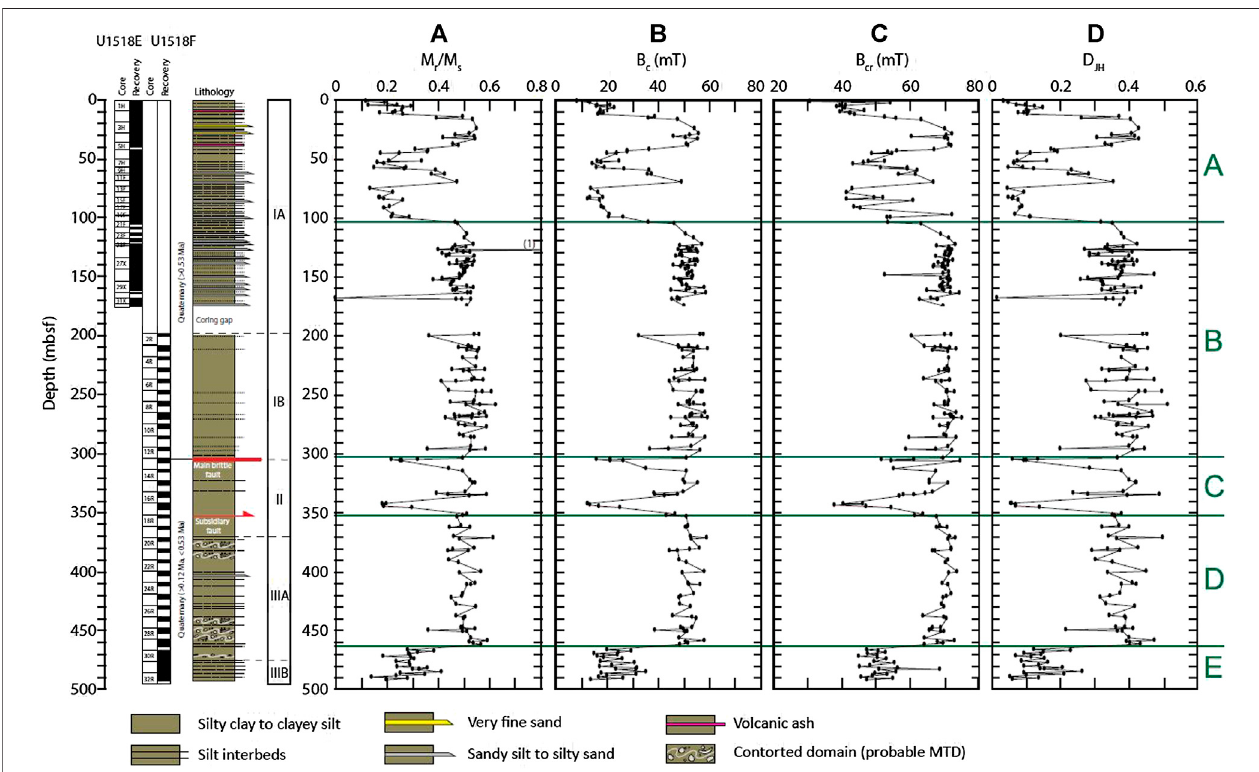
FIGURE 3 | Downhole magnetic hysteresis properties at Site U1518 (A) M r /M s ratio (B) coercivity B c (C) remanent coercivity B cr (D) D JH index. Zones A to E are de fi ned from coercivity variations. Core recovery, age and lithologic description are from Wallace et al. (2019).